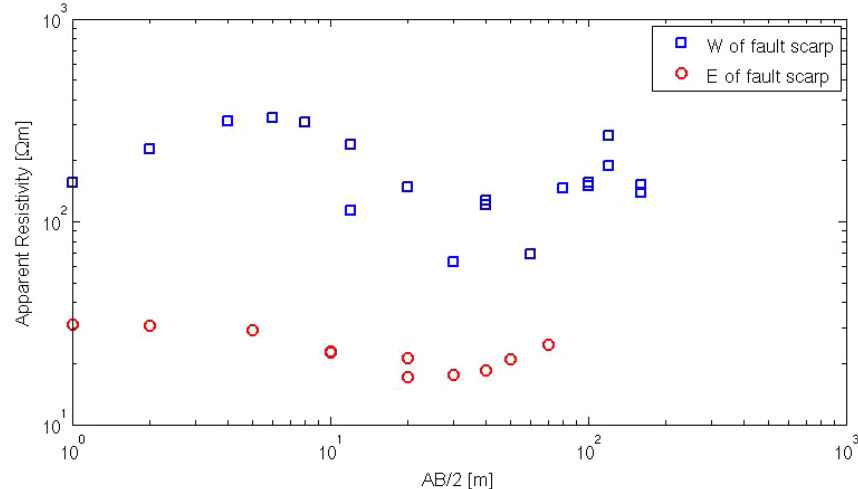
Figure A5. VES close to L2 profile. The results of both VESs are shown in this figure as blue squares for apparent resistivity on the western side of the fault scarp (SEV1 in Fig. 4) and red circles on the eastern side of the fault scarp (SEV2 in Fig. 4).